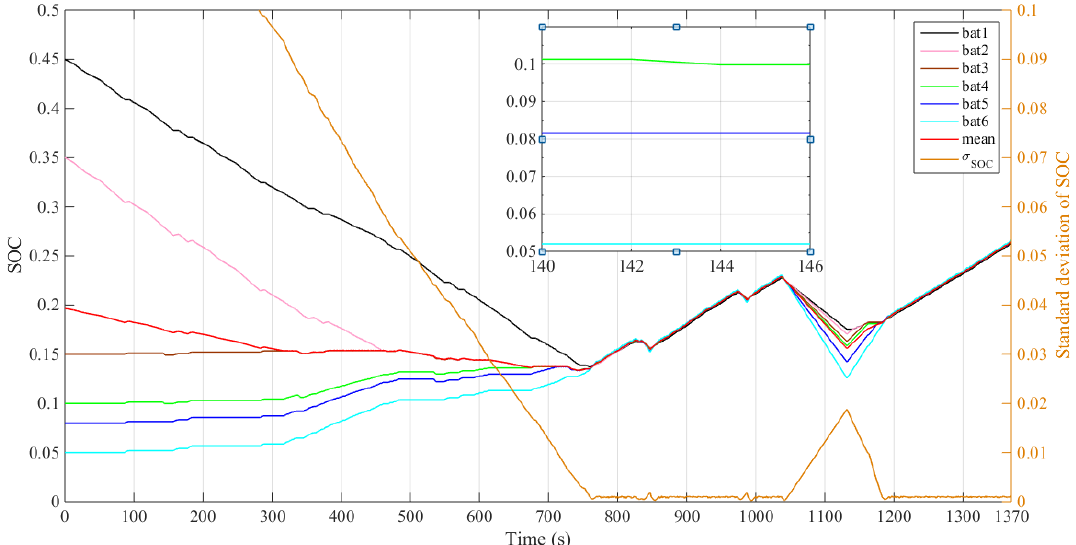
Figure 15. The SOC change of each battery.